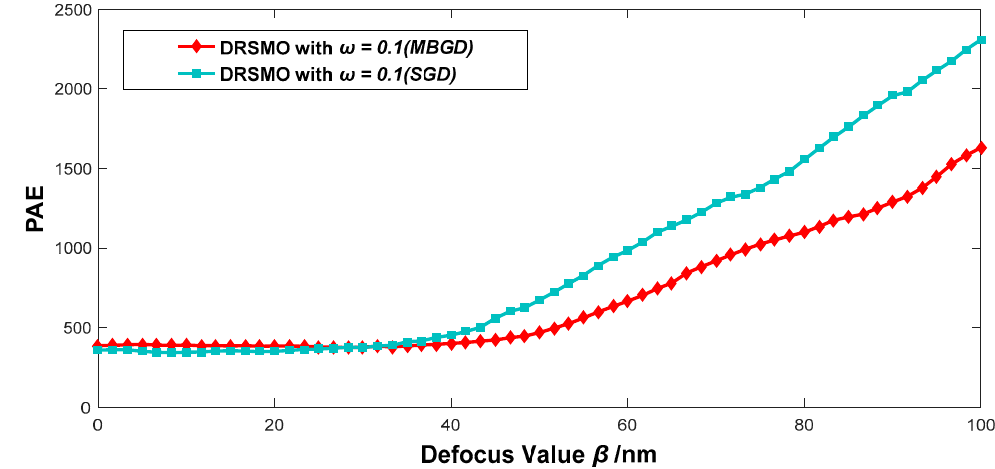
Figure 8. The defocus–PAE curves of target 1 for the DRSMO with the same weight factor ω = 0.1 which was proceeded by the SGD algorithm (jasper curve) and MBGD algorithms (red curve), respectively.